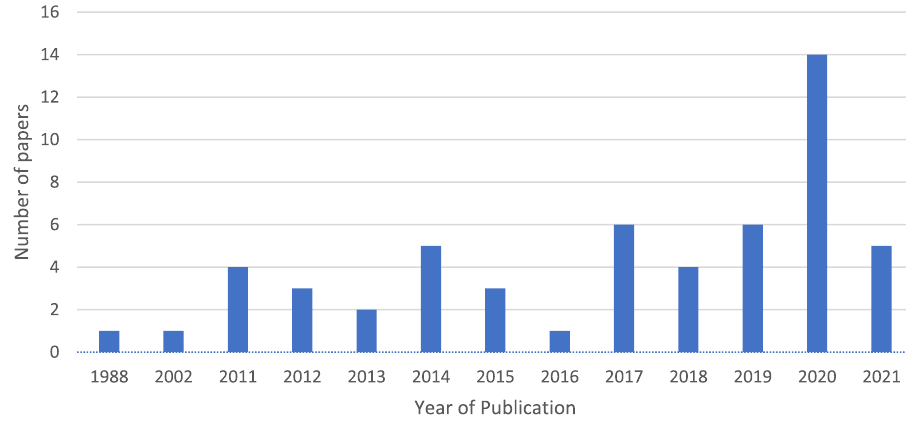
Fig. 2 Papers in selected journals about the benefits of technology adoption (SBTs) by